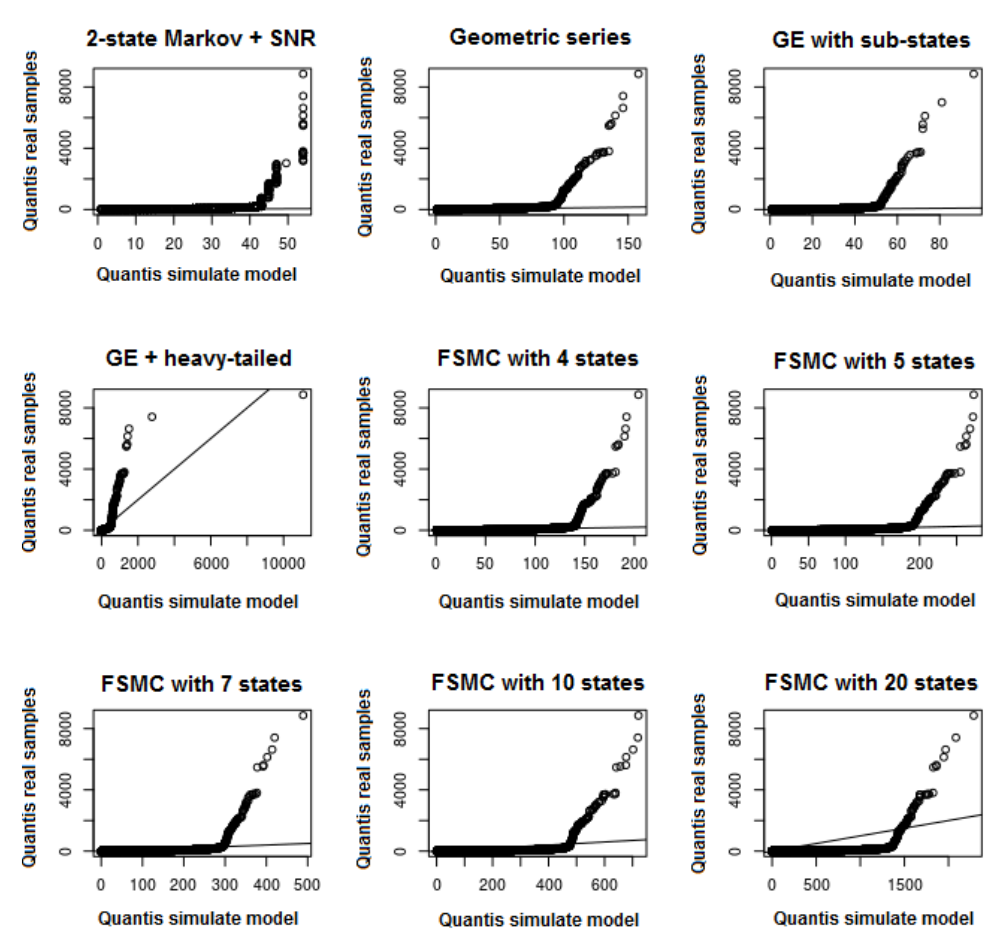
Figure 11. QQ-Plot: simulation model of related works with the real